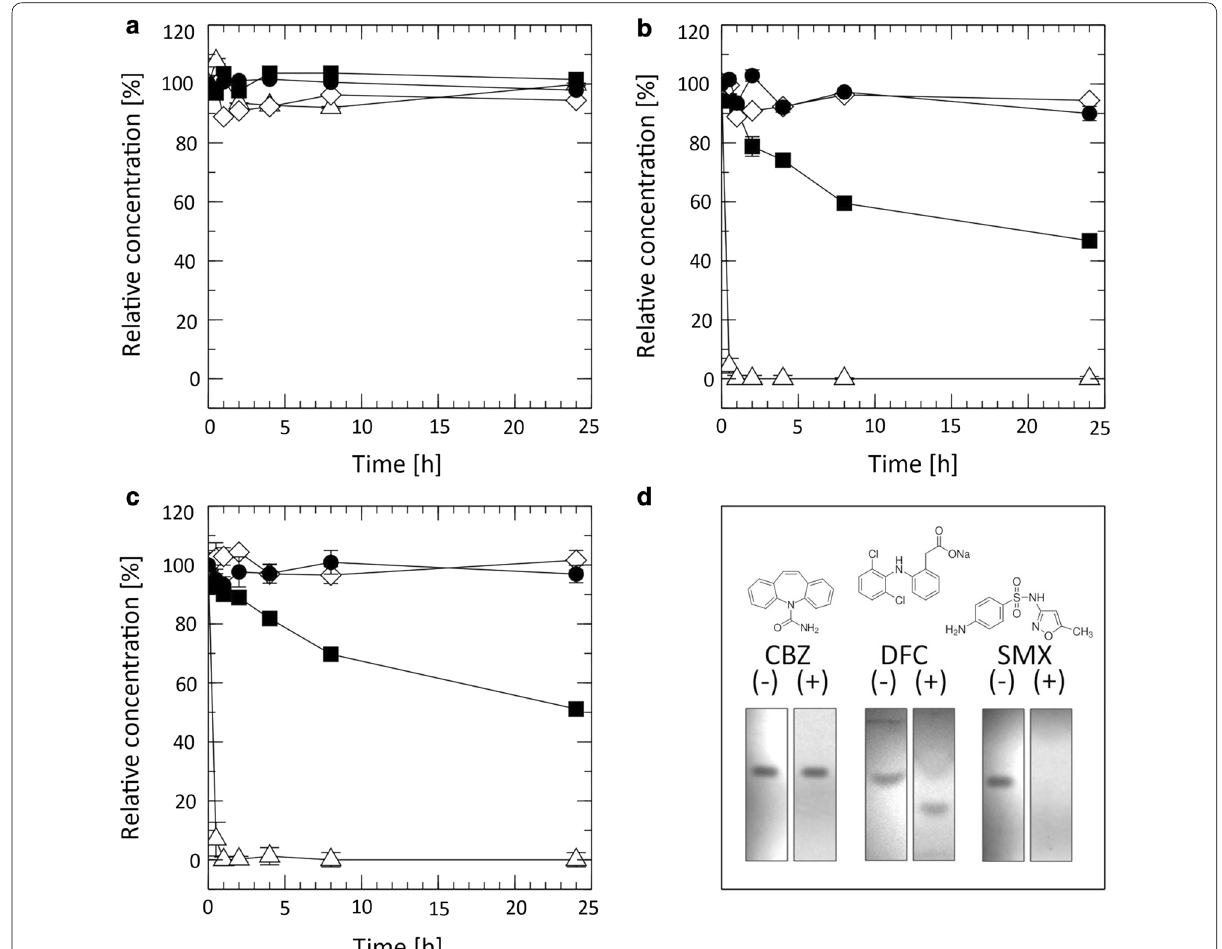
Fig. 7 Degradation courses of carbamazepine ( a ), diclofenac ( b ), and sulfamethoxazole ( c ). Reaction mixtures containing pharmaceutical and Tvlcc5 in the absence (black square) or presence of 1 mM ABTS (white up-pointing triangle) were compared with reaction mixtures containing pharmaceuticals only in the absence (black circle) or presence of 1 mM ABTS (white diamond). d Thin layer chromatography plates showing influence of ABTS ( ) on degradation of +